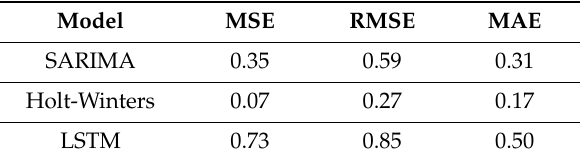
Table 2. Accuracy values from the execution of the predictive